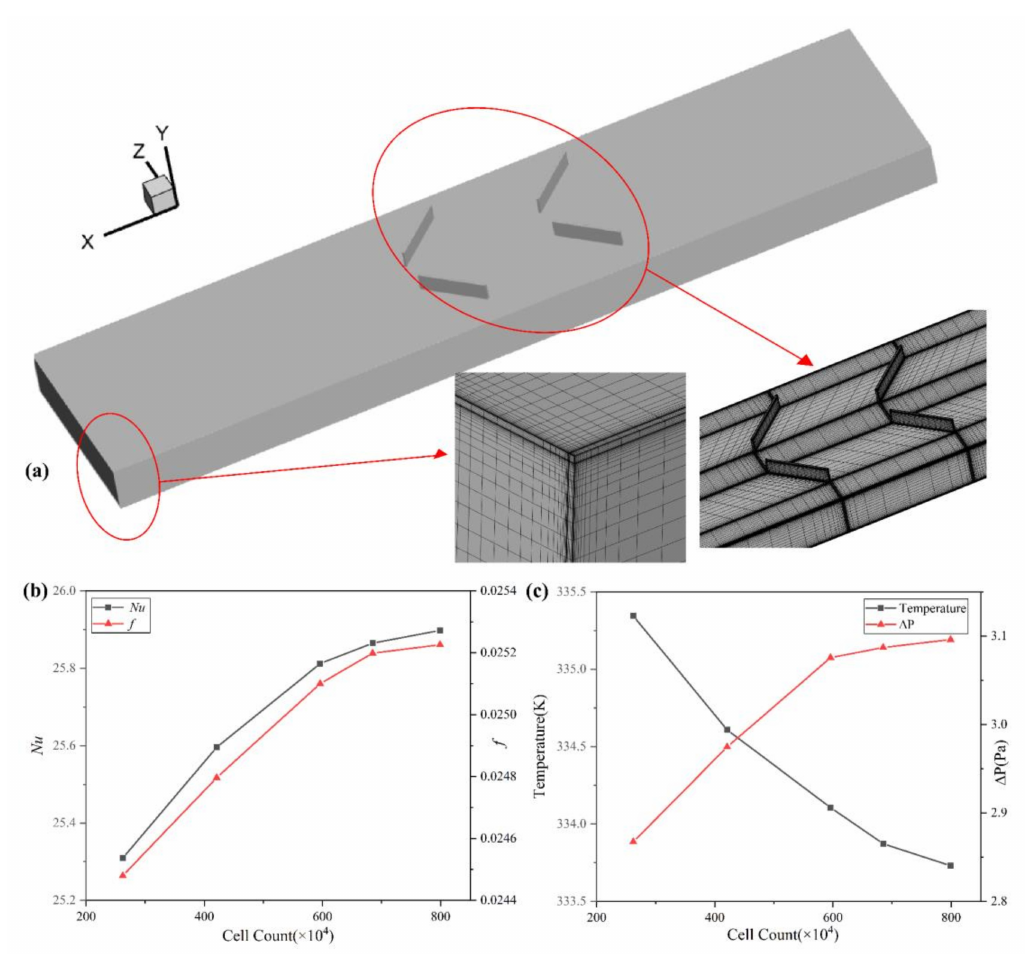
Figure 2. ( a ) Representative grids in numerical simulation, ( b , c ) grid independence test